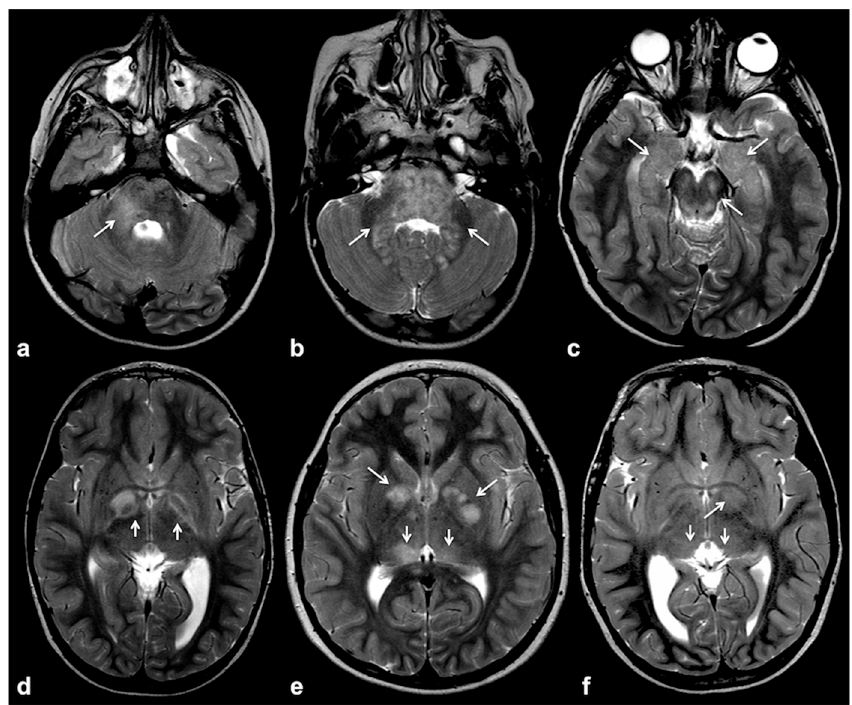
Figure 1. Typical focal abnormal signal intensity (FASI) localization to cerebellar pedicles and cerebellum ( a , b ), brainstem, cerebral peduncles and hippocampi ( b , c ), as well as basal ganglia ( d – f ) on axial TSE T2w MR images (white arrows).